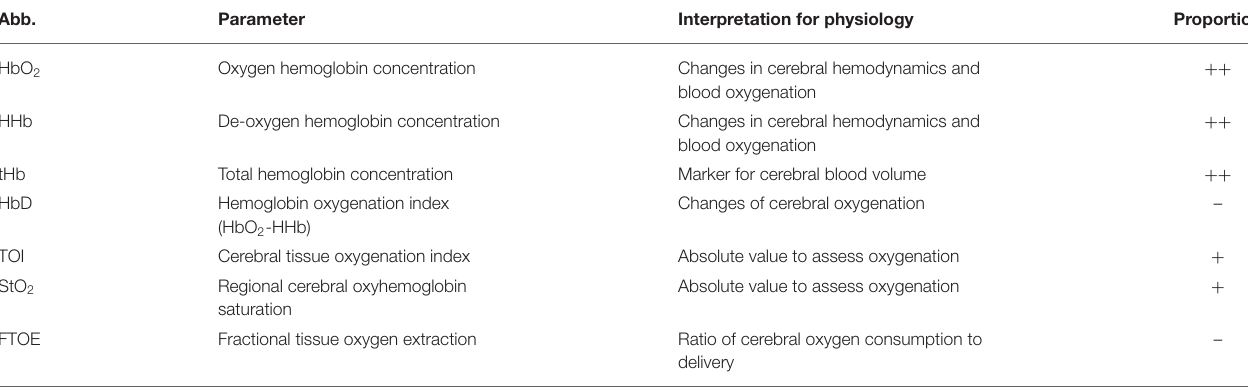
TABLE 2 | List of the most reported parameters in sleep studies using NIRS (12) and the proportion of their utilization.